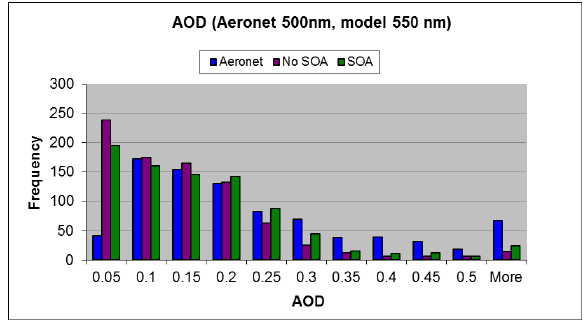
Figure 15. Distribution of measured and modelled AOD in the mid-visible Fig. 15. Distribution of measured and modelled AOD in the mid-